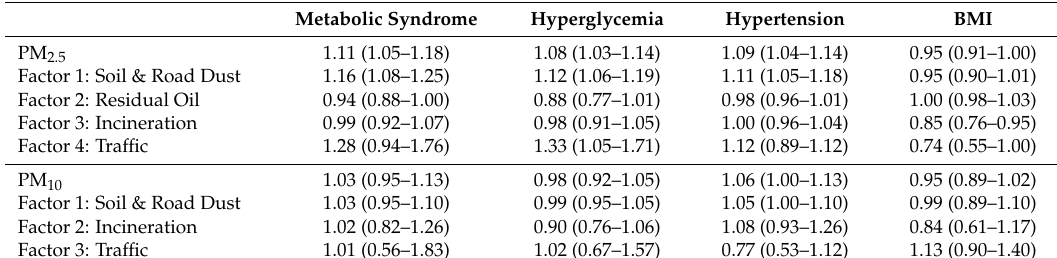
Table 3. Risk Ratios (RR) and 95% Confidence Interval (CI) per 10 µ g/m 3 increment of particulate matter (PM) and factor mass estimates.